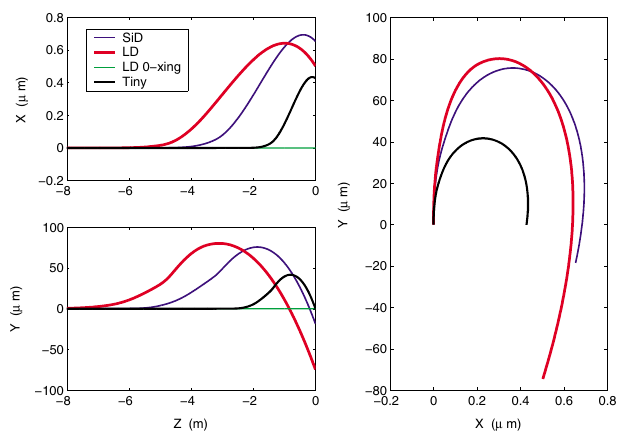
FIG. 6. (Color) Beam orbits obtained by tracking with four different solenoid models. IP is at z (cid:3) 0 m .